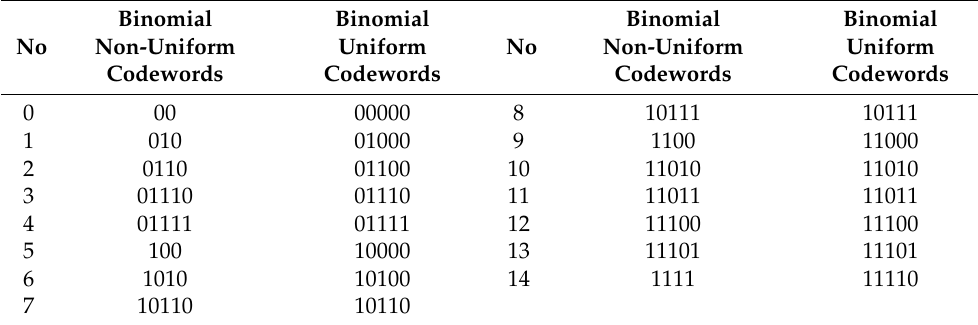
Table 2. Non-uniform and uniform binomial codewords with parameters n = 6, k =